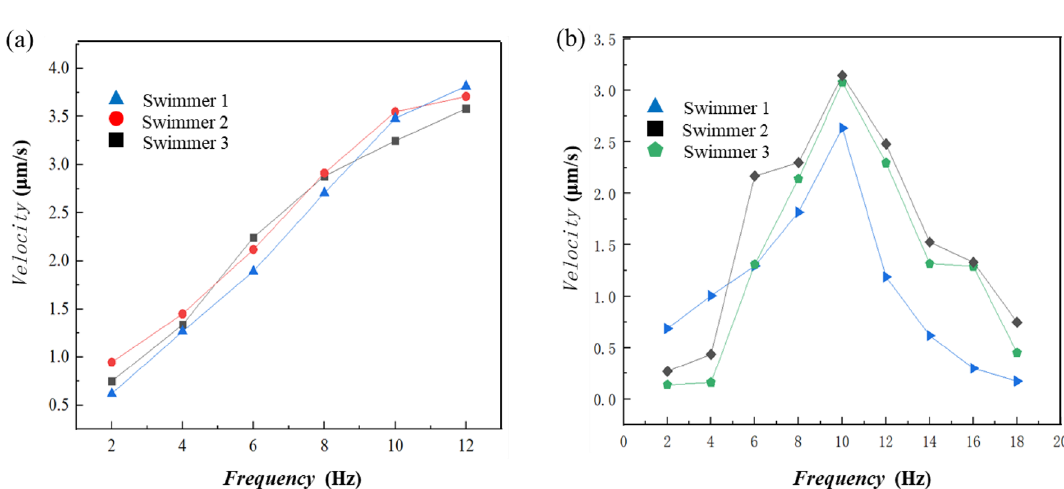
Figure 3. Velocity profiles of the nanorobots. ( a ) linear velocity profiles when the magnetic field frequency and strength increased proportionally. ( b ) nonlinear velocity profiles when the magnetic field strength remains constant at 2 mT while the frequency increases; step-out was observed at 10